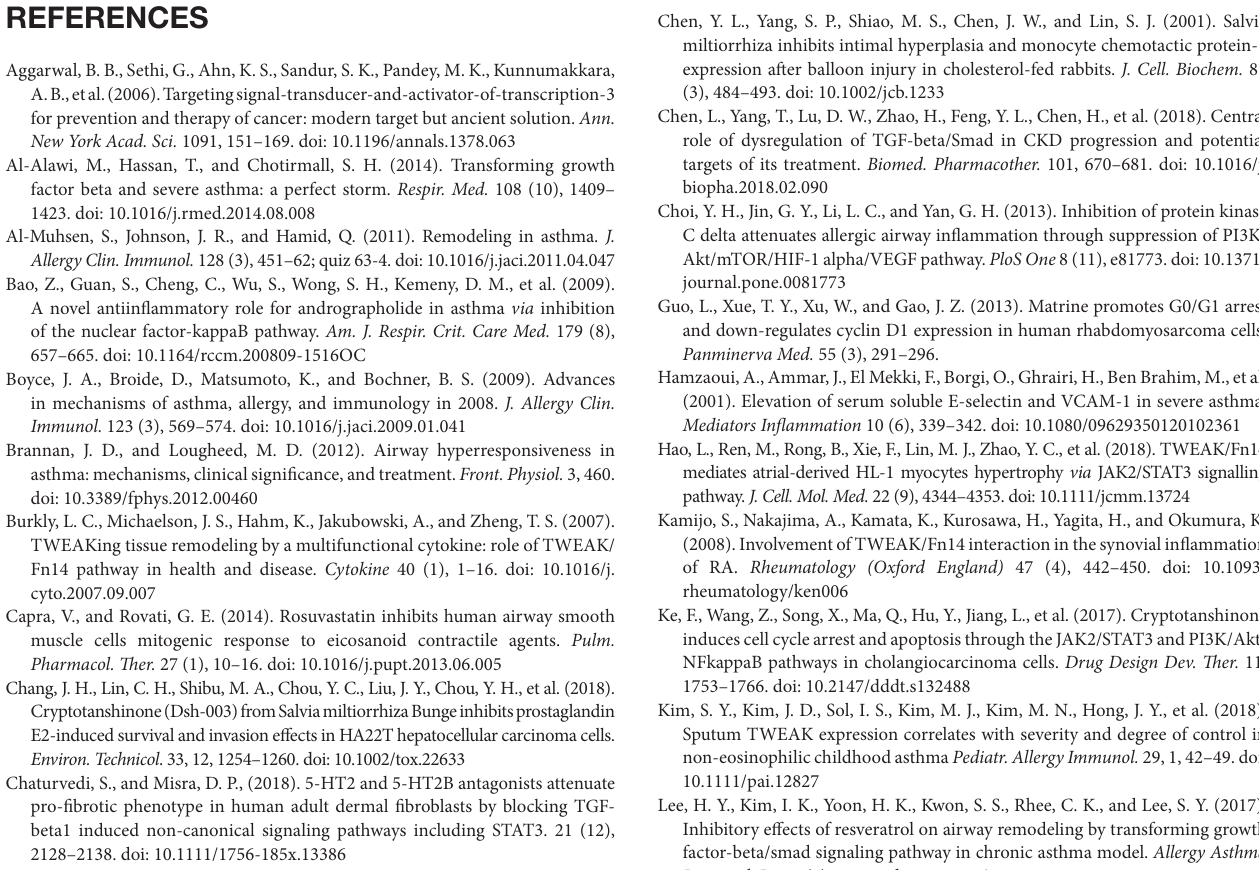
FIGURe S1 | Effect of CTS on the expression of PCNA in the lung tissues. Immunohistochemical staining was performed to assess the distribution of PCNA. Magnification was 100×; Scale bar = 200 μm. Data were shown as mean ± SEM (n = 8). Control (PBS-inhaled mice administered with PBS), OVA (OVA-inhaled mice administered with PBS), OVA+CTS 20/40 (OVA-inhaled mice administered with 20 mg/kg or 40 mg/kg CTS), and DEX (OVA-inhaled mice administered with